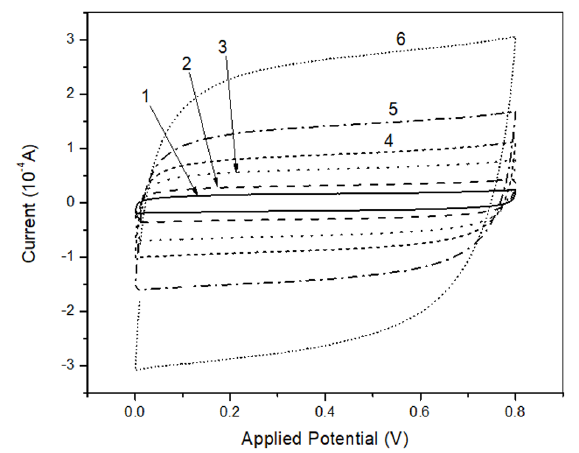
Figure 2: Cyclic voltammograms of EDLC obtained with the scan rate variation from 5 to 100 mV s -1 . [(1) 5 mV s -1 , (2) 10 mV